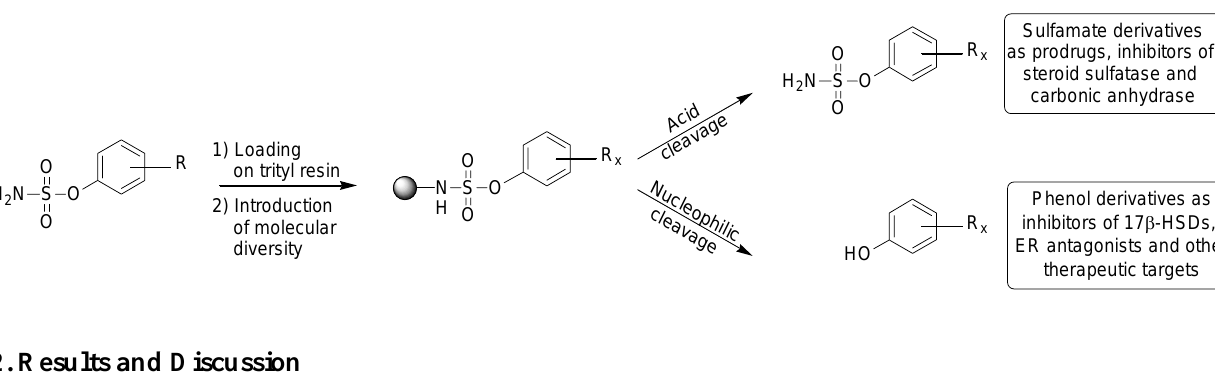
Figure 3. Versatility of the multidetachable sulfamate linker for generating sulfamate and phenol derivatives by acidic or nucleophilic cleavage,